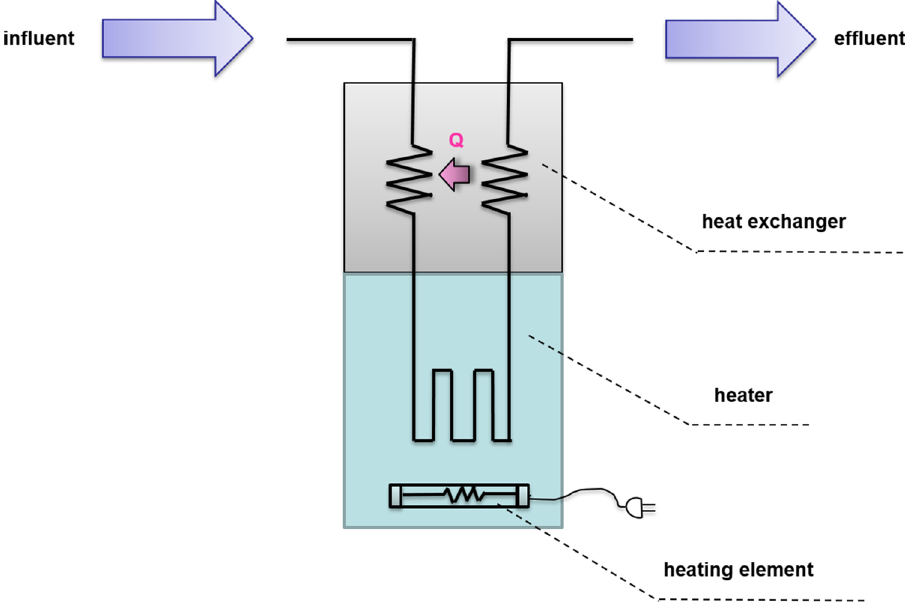
Fig. 1 Schematic diagram of the pilot disinfection